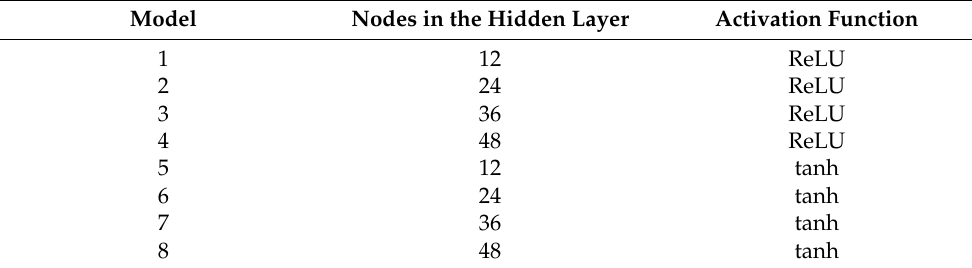
Table 2. Electrical load